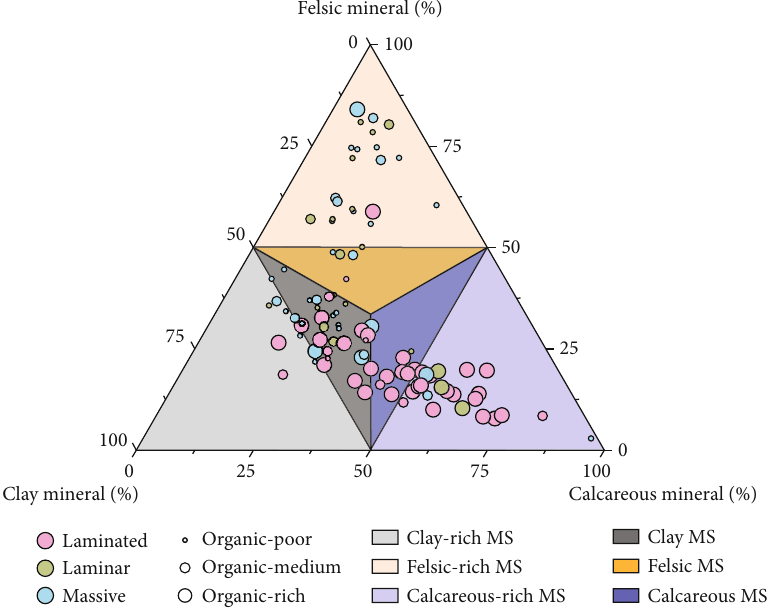
Figure 6: Lithofacies types of the mudstone and shale (MS) in the Es 1L of the Raoyang Sag.